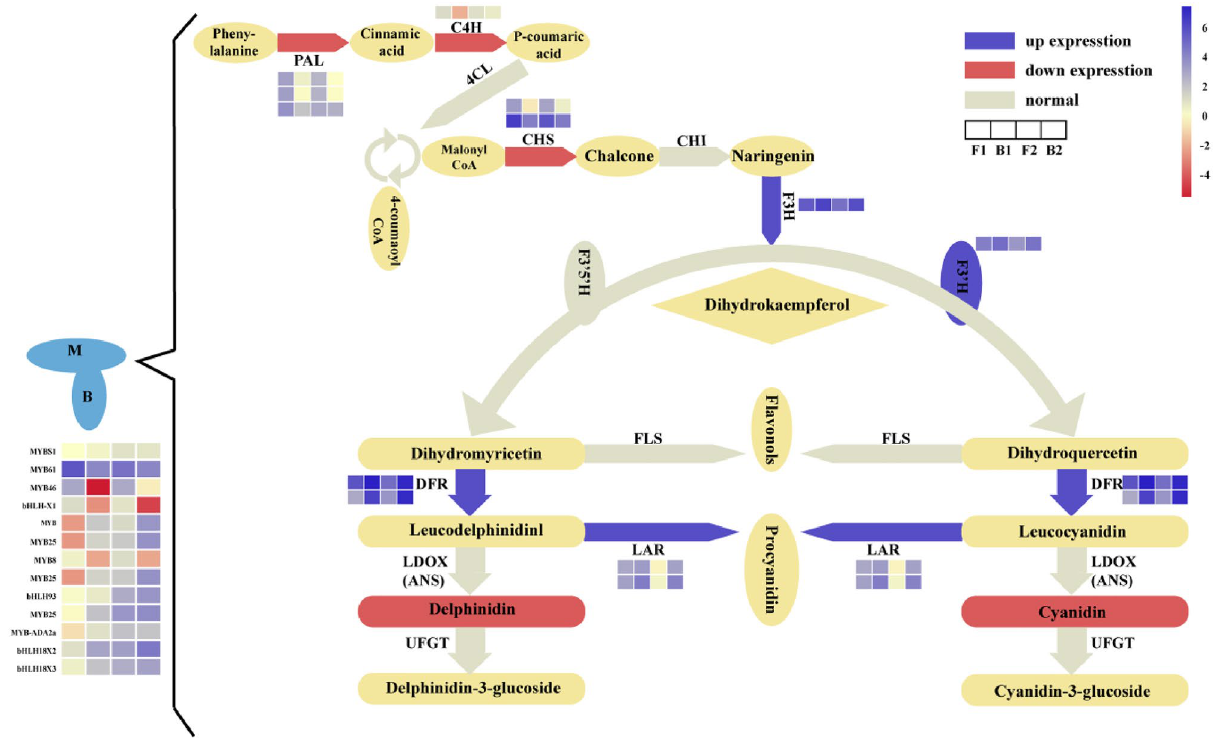
Figure 8. Combined analysis of transcriptome and metabolome of flavonoid biosynthesis. The red graphic represents the down-regulation of gene expression, the blue graphic represents the up-regulation of gene expression, and the gray graphic indicates that there is no significant difference in gene